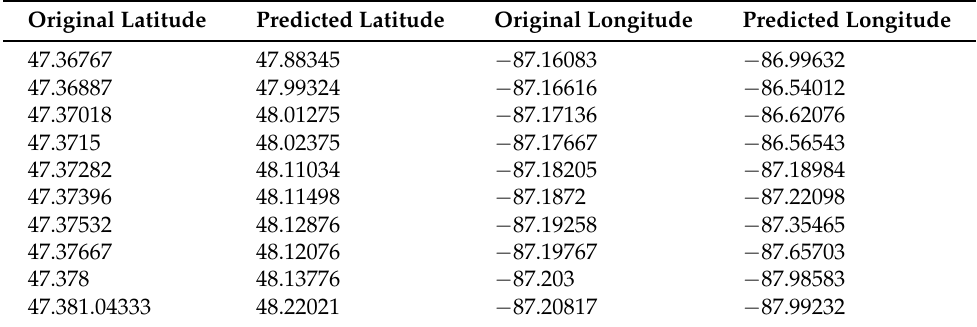
Table 3. Real data versus the predicted path segment. The predicted latitude has better accuracy than the predicted longitude.